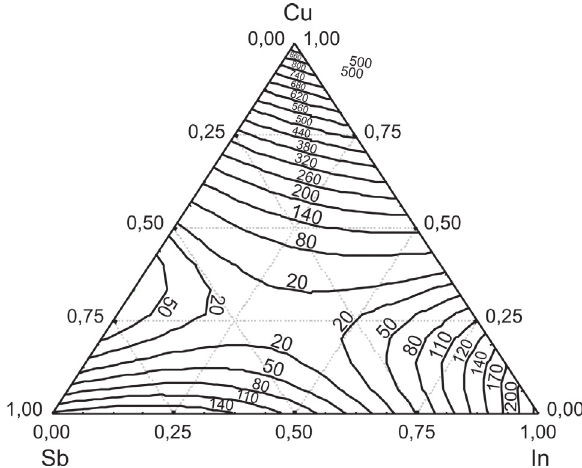
Figure 8. Iso-lines of hardness by Brinel for ternary Cu-In- Sb system.